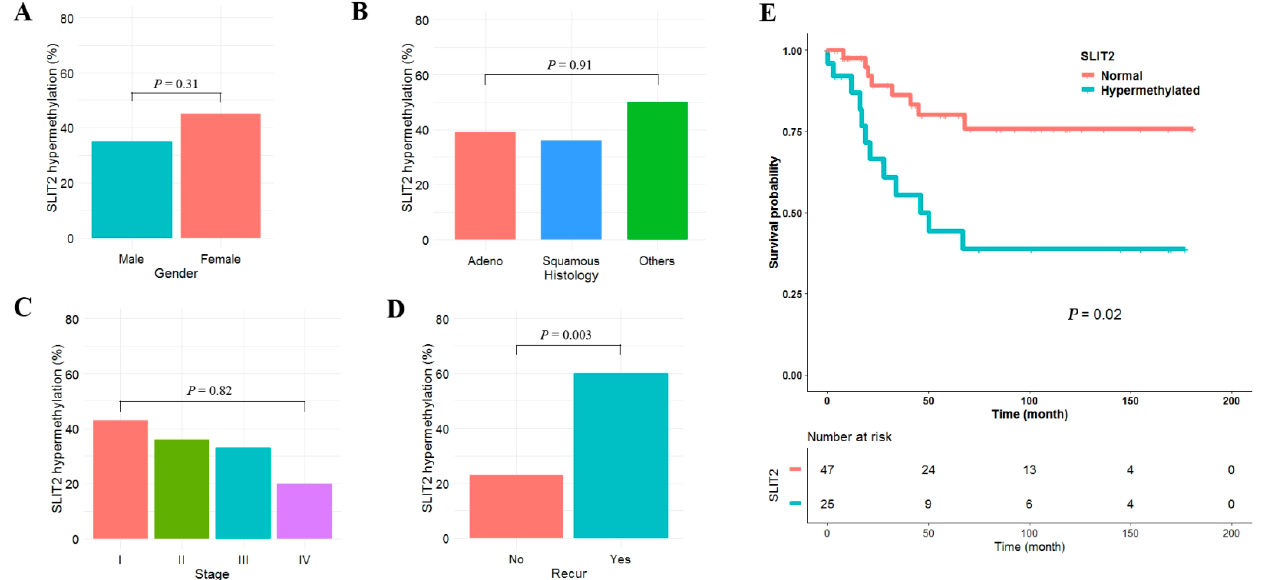
Figure 5. Negative effect of SLIT2 hypermethylation in plasma cell-free DNA on recurrence-free survival of NSCLC patients. ( A – D ) Methylation levels of SLIT2 in plasma cell-free DNA from 72 NSCLC patients were compared according to gender ( A ), histology ( B ), pathologic stage ( C ), and recurrence ( D ). “Adeno” and “Squamous” indicate “adenocarcinoma” and “squamous cell carcinoma”, respectively. p -values were based on Fisher’s exact test or Chi-square test. ( E ) The relationship between methylation level of SLIT2 in plasma cell-free DNA and recurrence-free survival was analyzed using Kaplan-Meier survival estimates, and p -value was calculated using the log-rank test. Table 1. Cox proportional hazards analysis of survival according to SLIT2 hypermethylation.